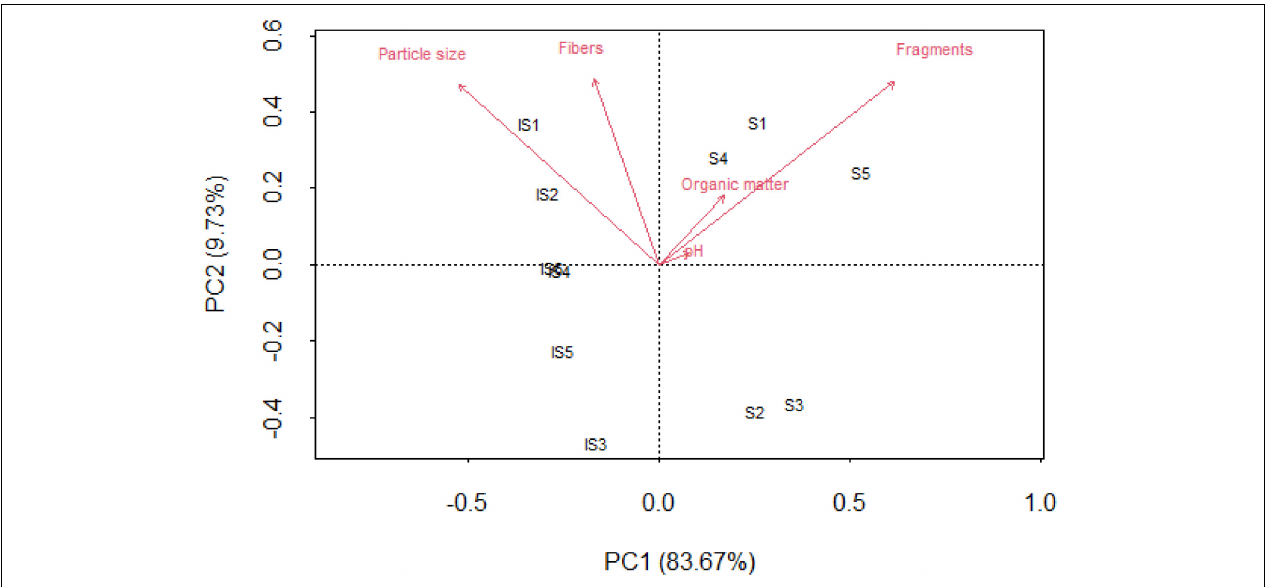
FIGURE 4 | Principal component analysis (PCA) between fibers, fragments, organic matter, particle size, and pH in soils and intertidal